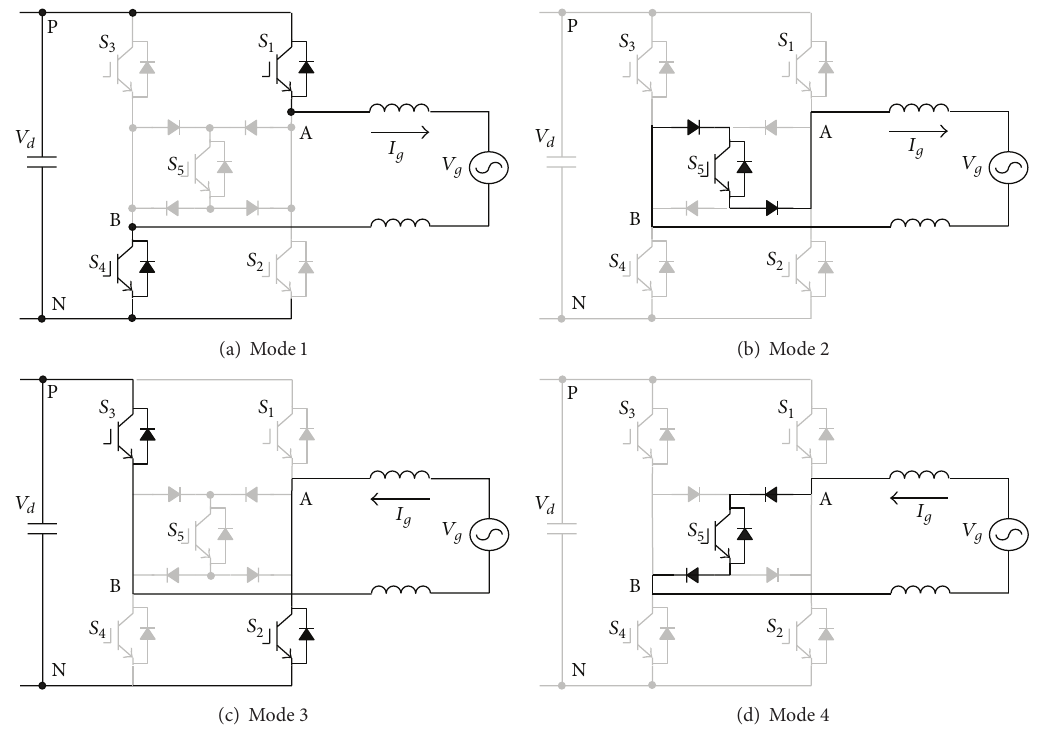
Figure 4: Operation modes of the